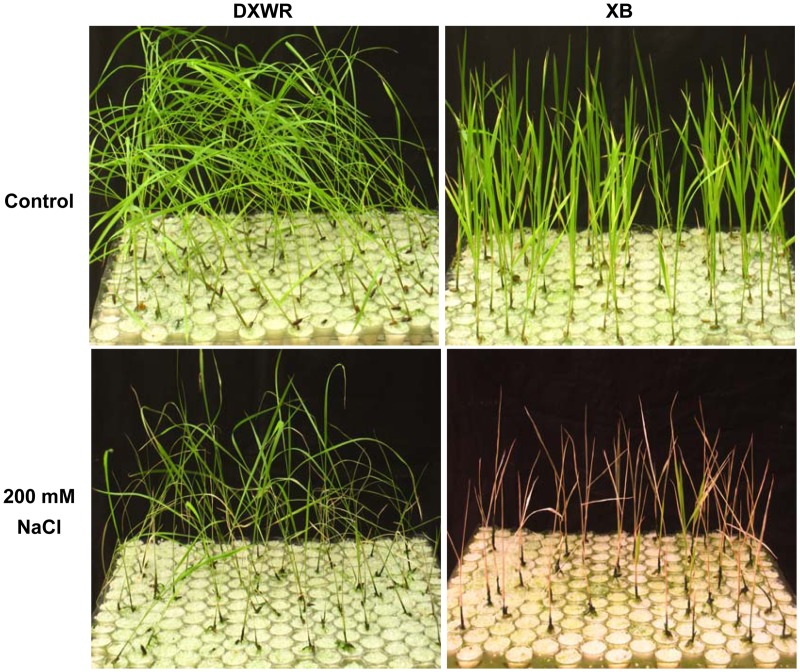
The seedlings of DXWR showed stronger salt resistance than the seedlings of XB.